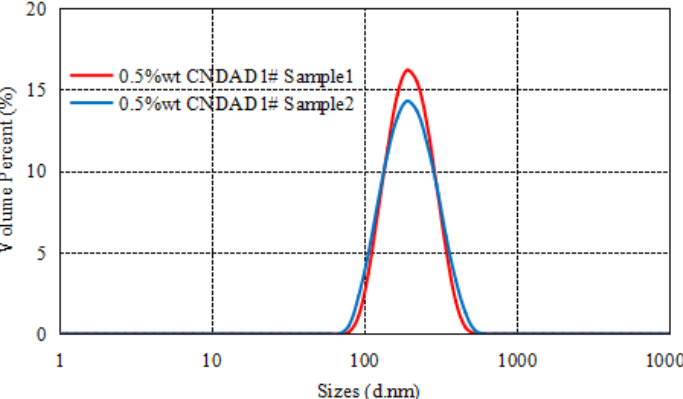
Figure 14. Nanometer particle test diagram of 0.5 wt% CNDAD1# solution [21].